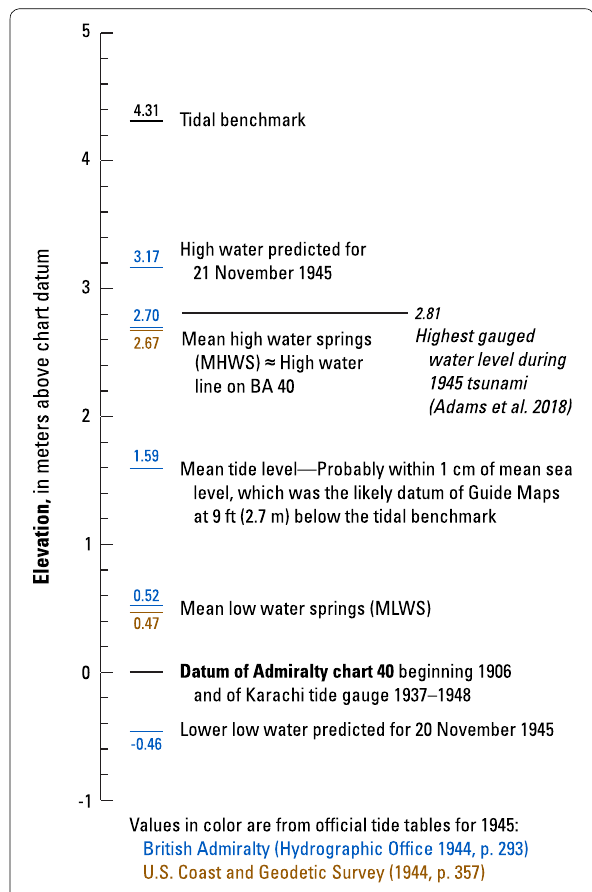
Fig. 3 Vertical datums for Karachi Harbour. References and other details in the